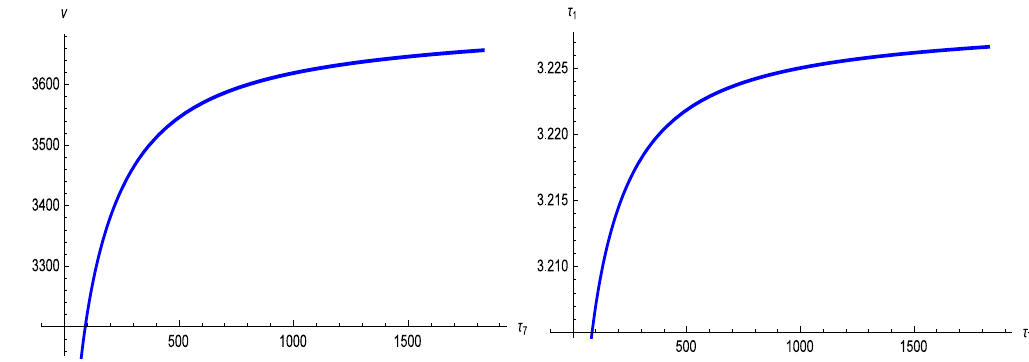
Figure 9 . Plot of the whole inflationary evolution in the ( τ ( τ 7 , τ 1 )-plane (on the right). Notice that the scales are different on the two axes since the inflaton travels mainly along the τ 7